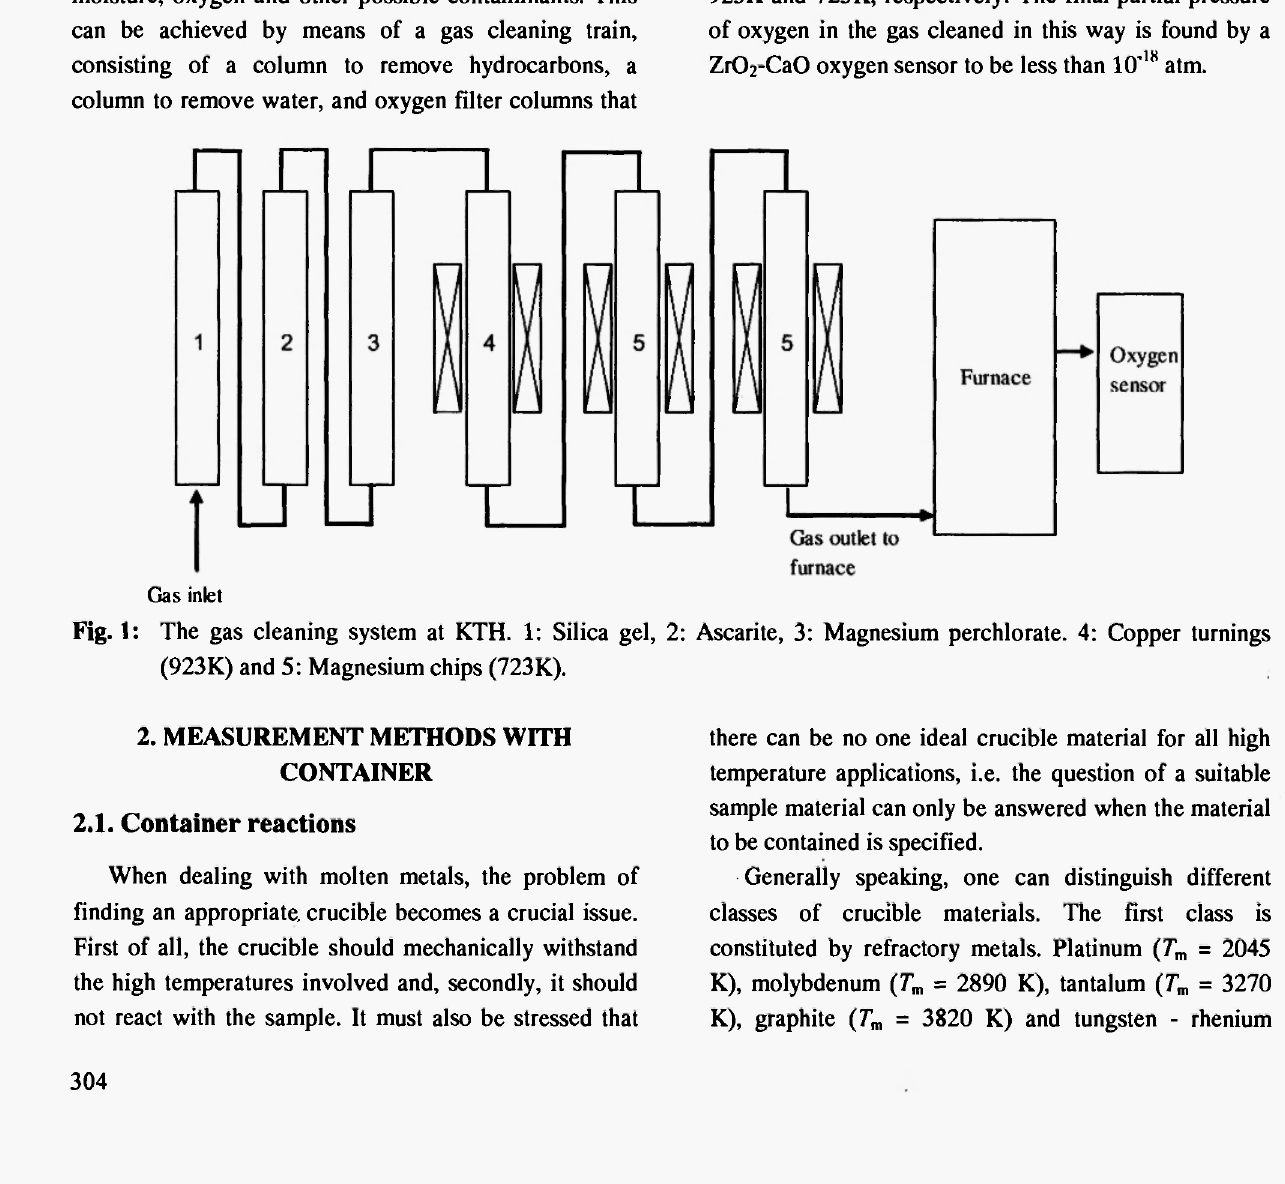
Fig. 1: The gas cleaning system at KTH. 1: Silica gel, 2: Ascarite, 3: Magnesium Perchlorate. 4: Copper turnings (923K) and 5: Magnesium chips